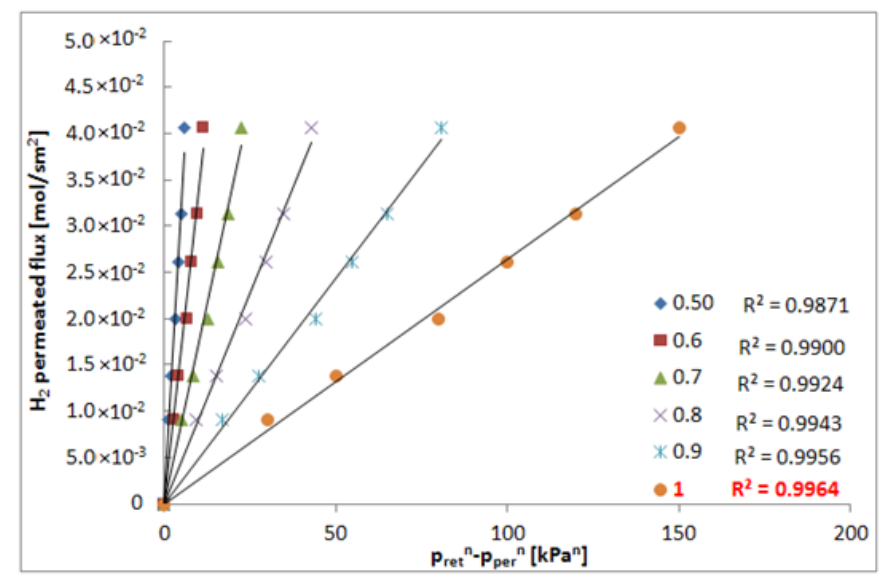
Figure 3. H 2 permeating flux vs . the driving force at different “n” and T = 420 ° C. Table 2. Permeation test results after 1100 h of composite membrane under continuous operation at 420 °C.